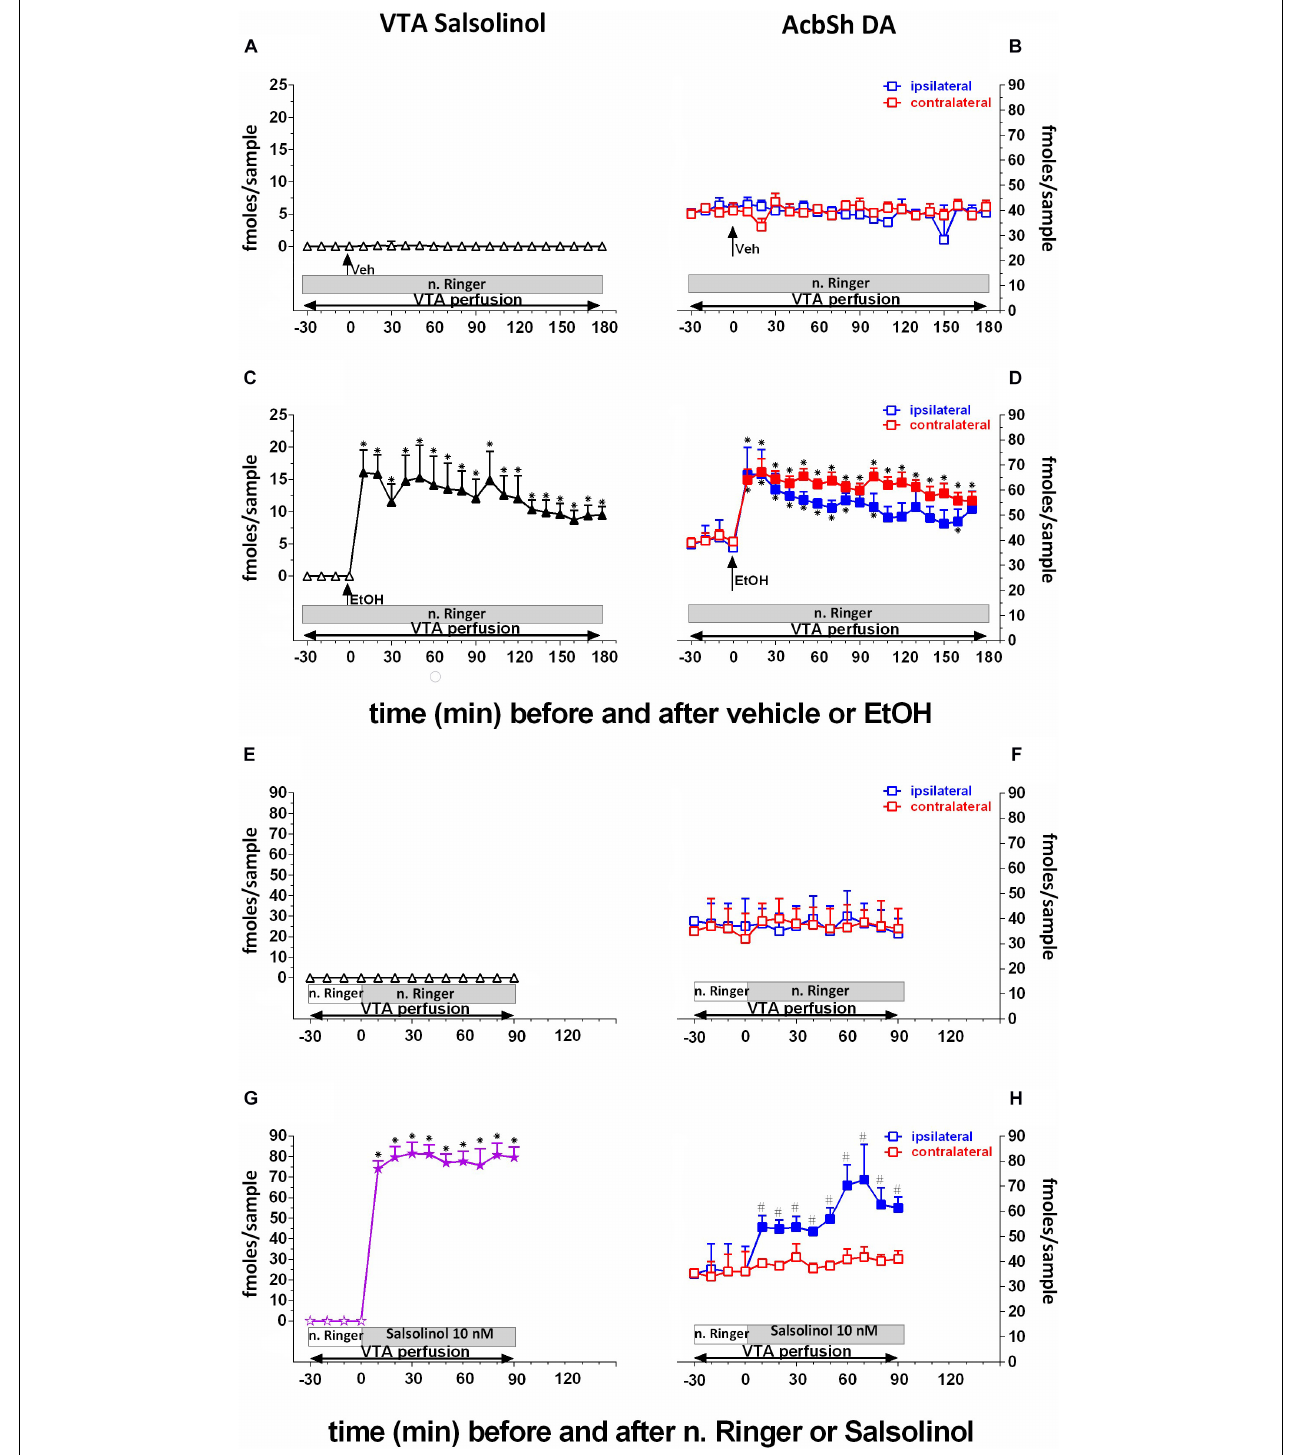
FIGURE 3 | Effects of intragastric administration of vehicle (tap water, 10 ml/kg) [ (A) N = 6, (B) N = 8] or ethanol (EtOH) (1 g/kg, 20% v/v) [ (C) N = 11, (D) N = 11] or of reverse dialysis application in the pVTA of normal Ringer ( n . Ringer) [ (E) N = 6, (F) N = 8] or salsolinol (10 nM) [ (G) N = 9, (H) N = 9], on pVTA salsolinol (A,C,E,G) and on ipsilateral and contralateral AcbSh DA (B,D,F,H) dialysates. The purple color was used here to highlight the fact that indeed these concentrations of salsolinol were from the reverse dialysis application of salsolinol (10 nM)-enriched n. Ringer. Horizontal bars depict the contents of the pVTA perfusion fluid along the experiments. Vertical arrows indicate the last pVTA or AcbSh sample before vehicle or EtOH administration. Filled symbols indicate samples representing p < 0.001 vs. basal; ∗ p < 0.01 vs. vehicle administration; # p < 0.01 vs. contralateral area.